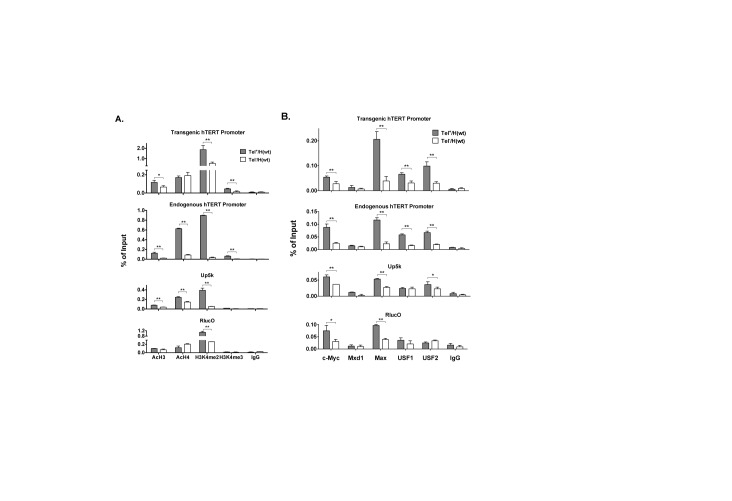
Chromatin states of integrated H(wt) BAC reporters in Tel+ and Tel− cells. (A) Histone modifications at the transgenic and endogenous hTERT promoters. (B) Association of EBPs to the transgenic and endogenous hTERT promoters. Chromatin fragments from Tel+ H(wt) and Tel− H(wt) cells were precipitated using antibodies against specific histone modifications (A) or EBPs (B), followed by quantitative PCR analyses. Shown are precipitated fragments as percentages of input chromatin. AcH3 and AcH3 refer to acetylated histone H3 and H4, respectively. H3K4me2 and H3K4me3 are di- and tri-methylated H3K4. Up5k and RlucO are PCR amplicons at 5-kb upstream of the hTERT promoter and 3′ end of Rluc ORF. *, P < 0.05; **, P < 0.01, by Student's t test.